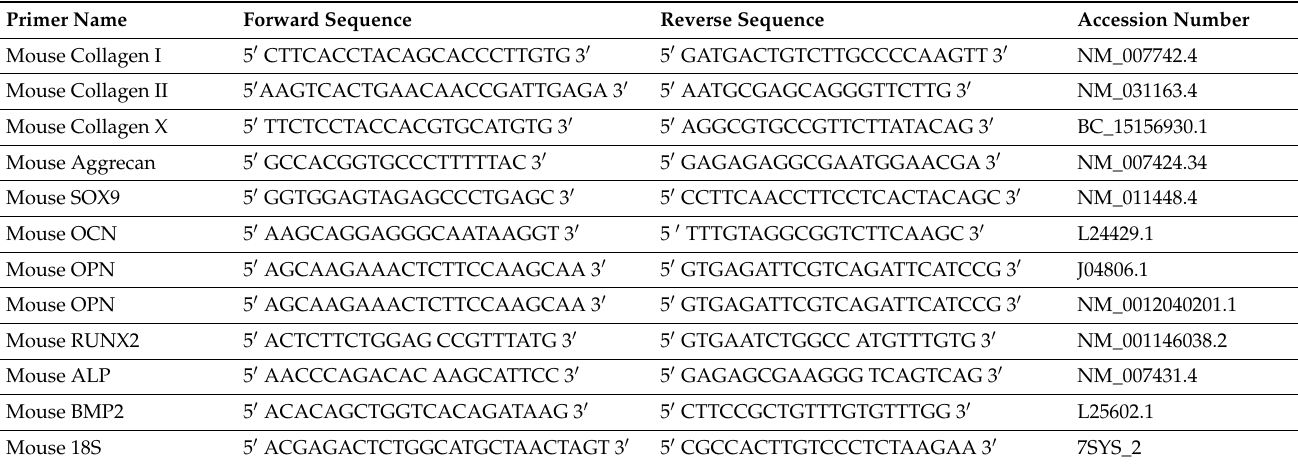
Table 2. List of primer names, oligo sequences and accession